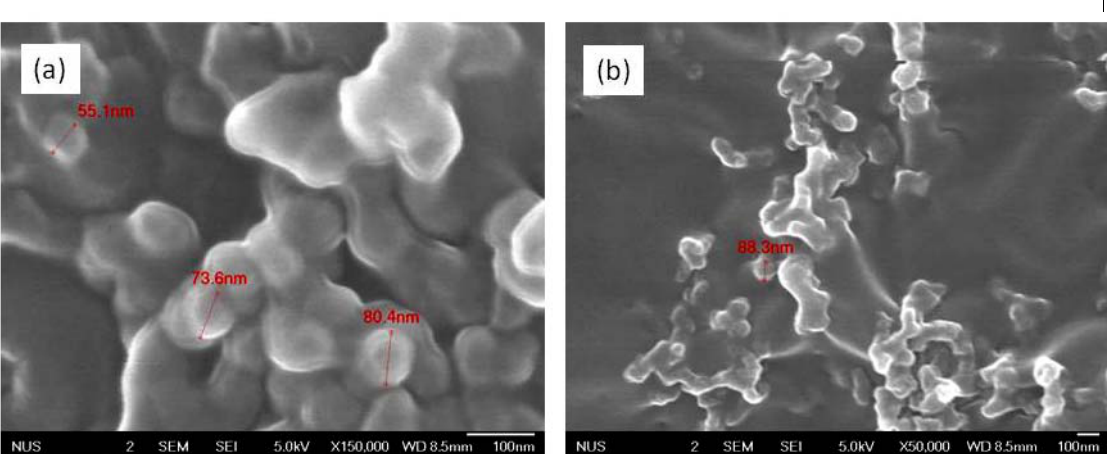
Figure 2. (a) FESEM image of the Fe (b) FESEM image of the Fe